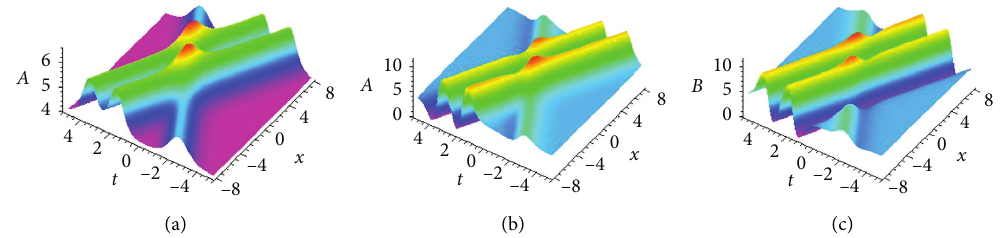
Figure 5: The three-soliton solution (28) with (a) b